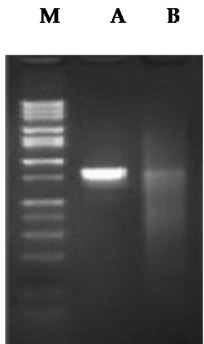
Figure 3. Gel electrophoresis picture of C- Φ KAZ14 NP ( A ) and naked Φ KAZ14 bacteriophage ( B ) treated with the enzyme pepsin and incubated at 45 ˝ C for 10 min.